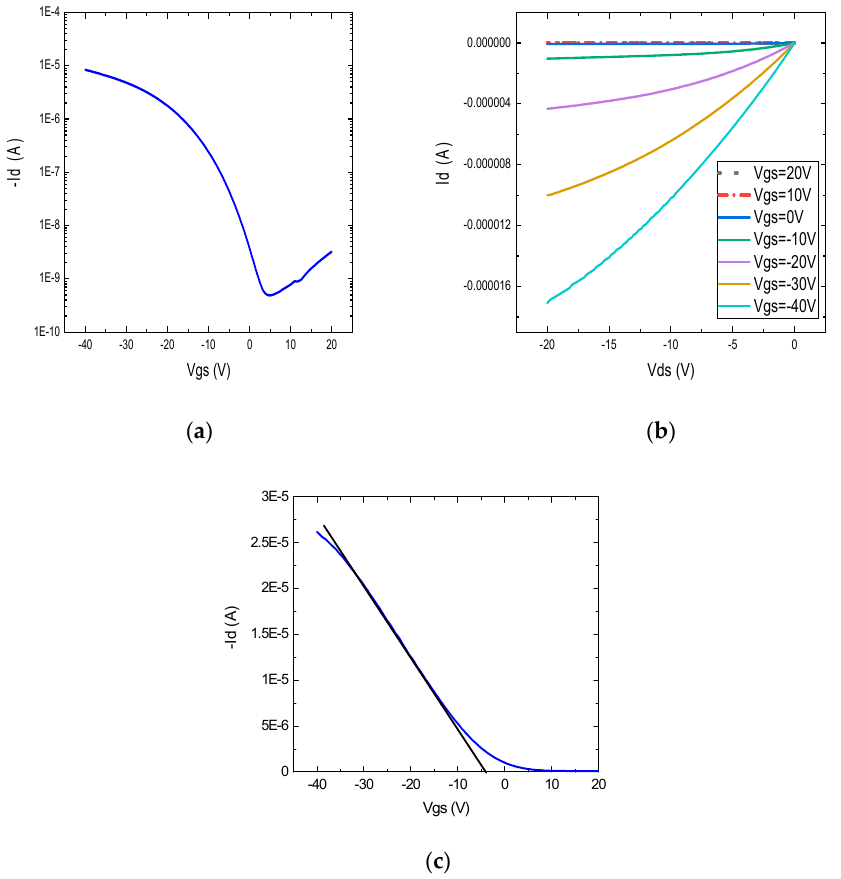
device, where the highest slope intersects the gate voltage axis, as shown in Figure 9c.